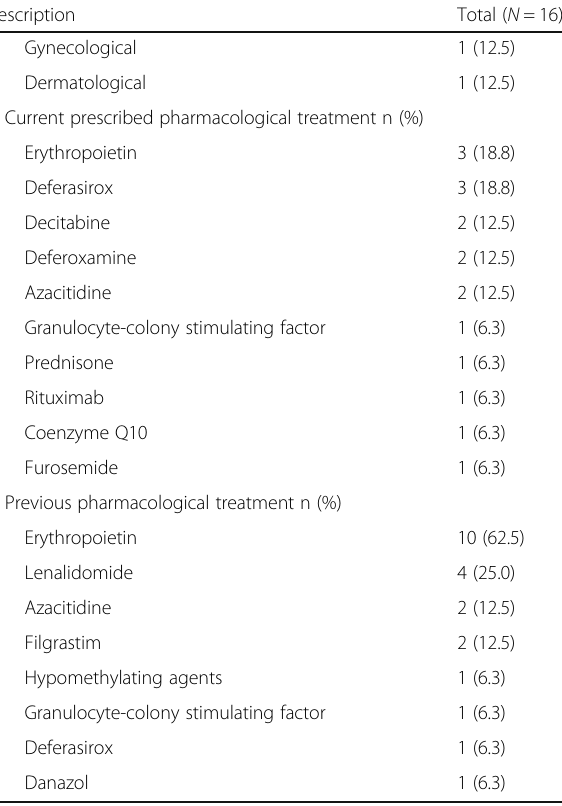
Table 1 Patients ’ characteristics